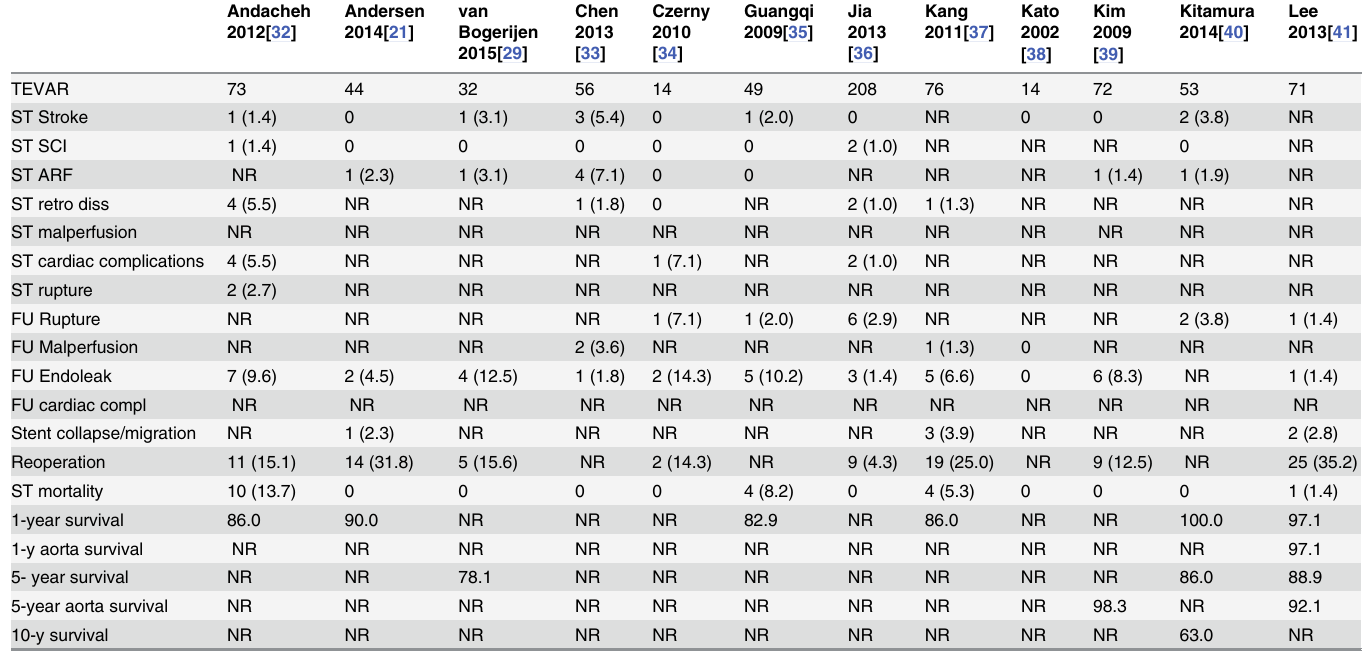
Table 2. Complications and survival